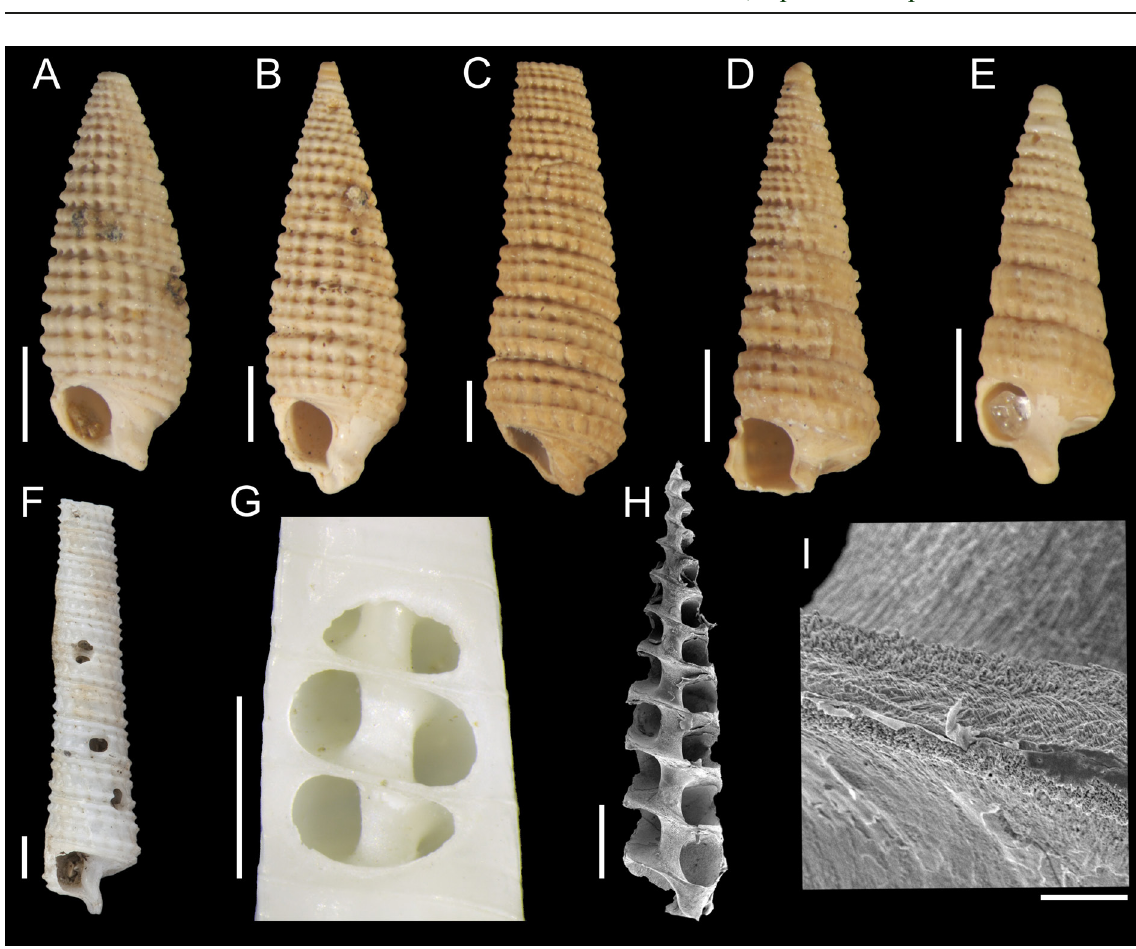
place currently known as ‘Aterro do Flamengo’, Rio de Janeiro, Brazil: MZSP 83618 (A), MZSP 42715 (B–E). F . Shell of Inella gigas (Hinds, 1843) with predation marks, obtained from Fernandes & Pimenta (2019b). G . Shell of Strobiligera gaesona (Dall, 1927) with a large predation mark. H . SEM micrograph of the columella of Cosmotriphora melanura (C.B. Adams, 1850), MNRJ 33138*. I . SEM micrograph of shell layers of the columella of Nototriphora decorata (C.B. Adams, 1850), MNRJ 32763*. Scale bars: A–H = 1 mm; I = 50